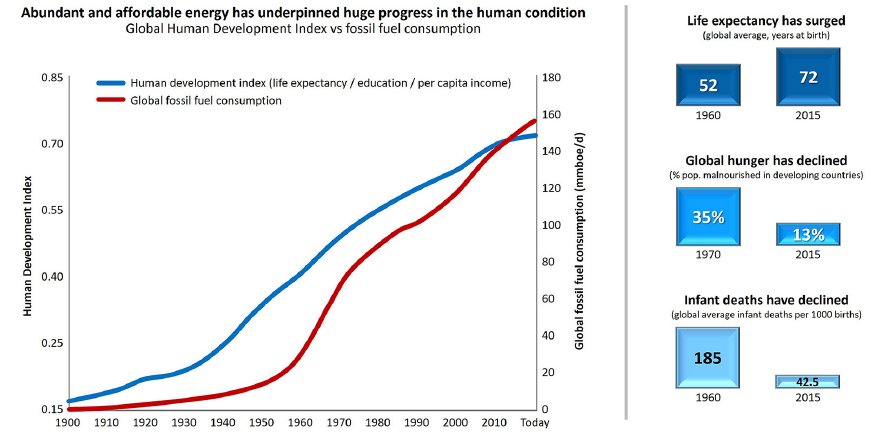
Fig. 1. – Left: energy consumption and quality of life. Right: abundant and affordable energy from fossil fuels has underpinned huge improvements in the quality of life for billions of people around the world for more than a